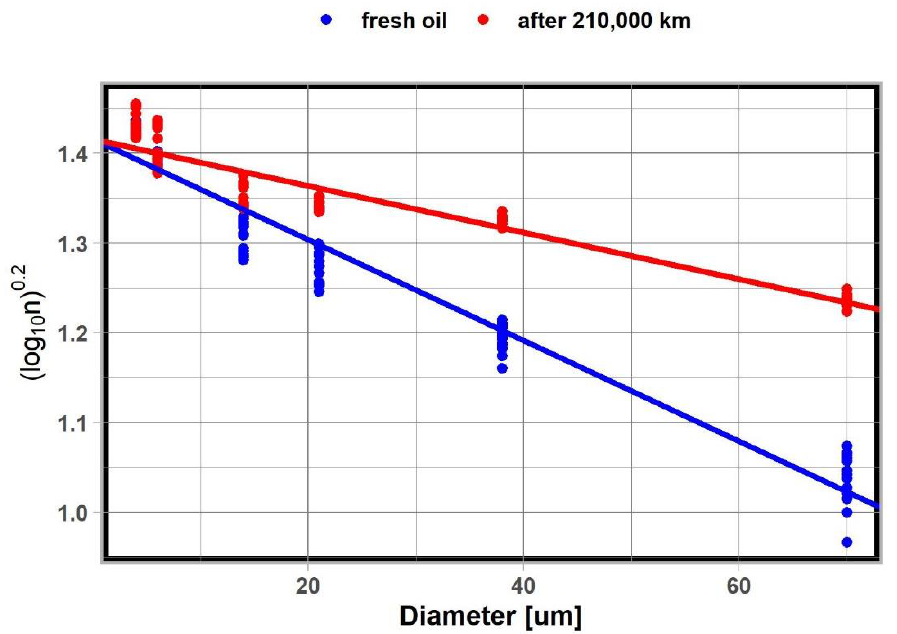
Figure 10. Regression model of particle content as a function of particle diameter of fresh and used (210,000 km) gear oil SAE 75W-90. Table 5. Basic parameters of the linear regression model for oil 75W-90.